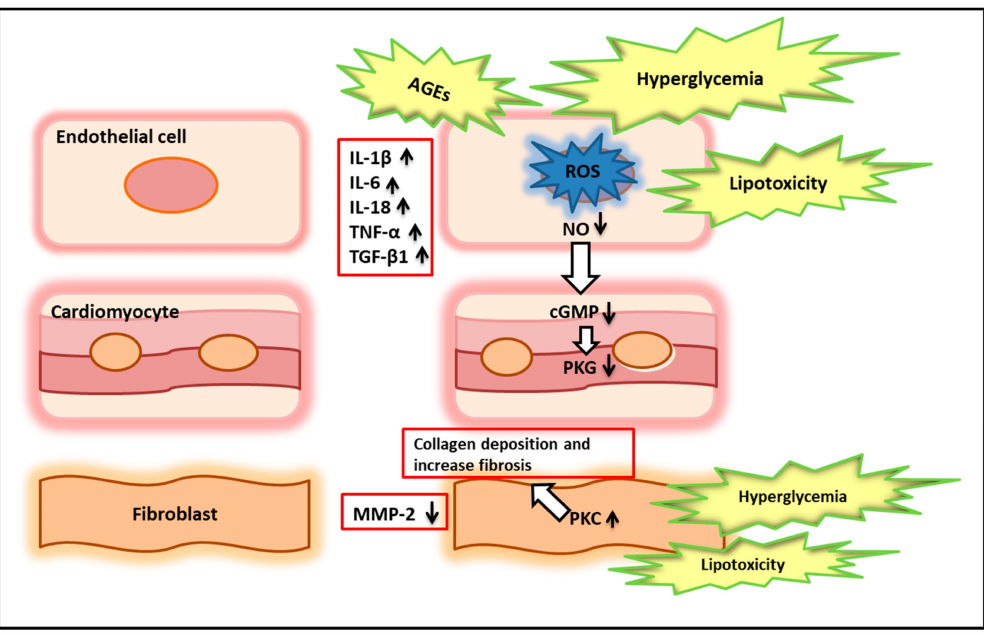
Figure 1. Cardiovascularalterationsandsignaldysfunctionsindiabeticcardiomyopathy. AGEs:advanced glycation end products; ROS: reactive oxygen species; NO: nitric oxide; cGMP: cyclic guanosine monophosphate; PKG: protein kinase G; PKC: protein kinase C; MMP-2: matrix metalloproteinase 2; IL: interleukin; TNF- α tumor necrosis factor alfa; TGF- β 1: transforming growth factor beta